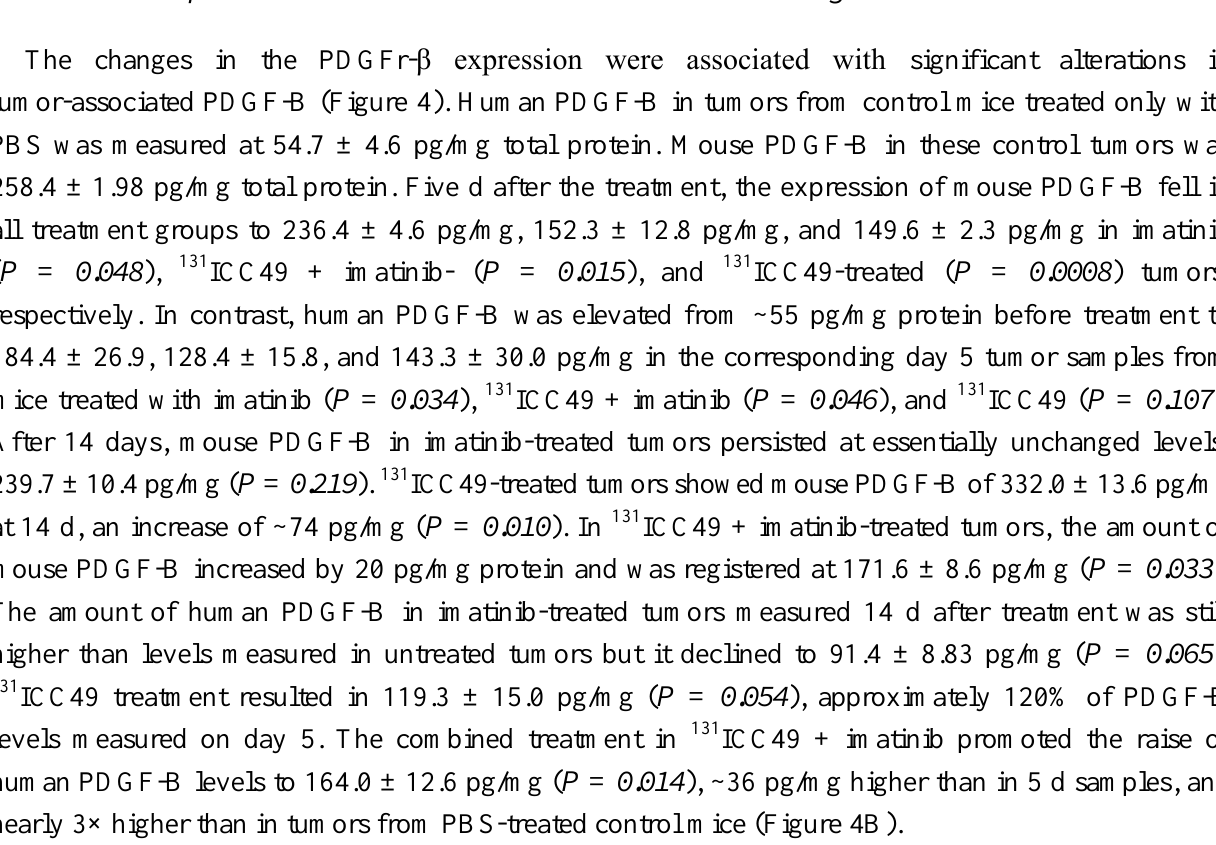
Figure 4. Time- and treatment-dependent changes in the expression of mouse PDGF-B ( A ) and human PDGF-B ( B